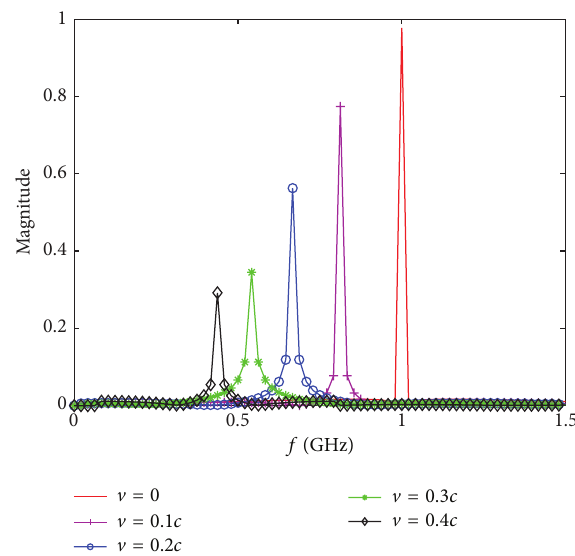
Figure 4: Time-domain scattered waveforms of the conducting surface moving along the + 𝑧 -axis.